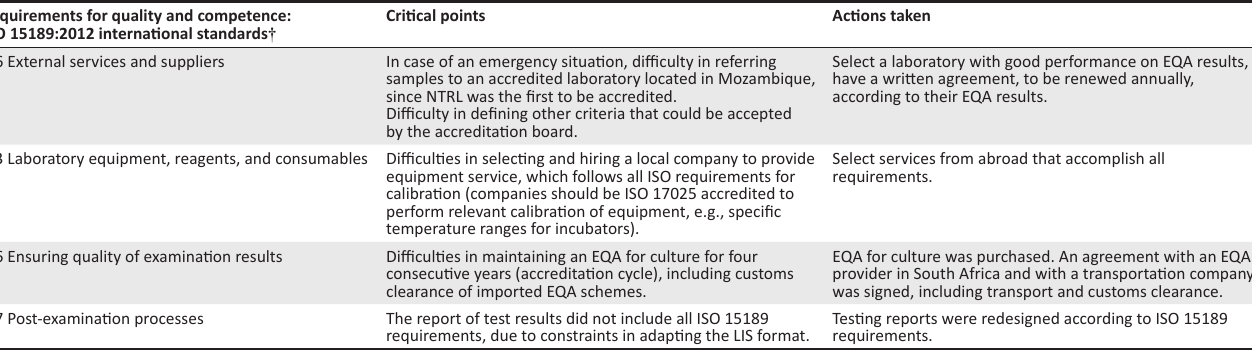
TABLE 2: Main challenges experienced and actions taken to accomplish ISO 15189:2012 requirements for accreditation of the National Tuberculosis Reference Laboratory, Mozambique, 2011–2013. Requirements for quality and competence: ISO 15189:2012 international standards